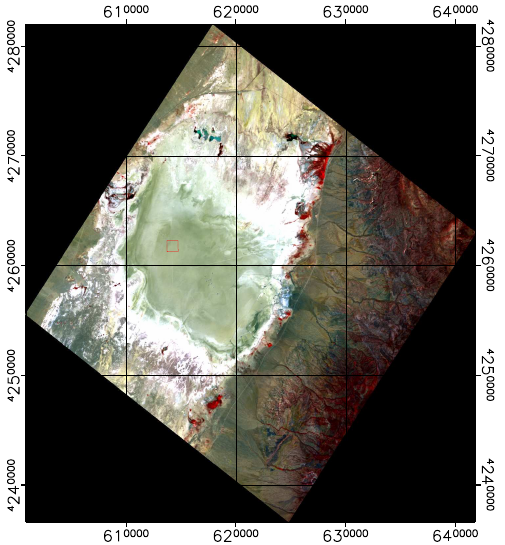
Figure 10. RVUS, 28 June 2019, L2A CIR image, non-linear stretch; coordinates given in WGS-84, UTM Zone 11 N. RadCalNet location as red